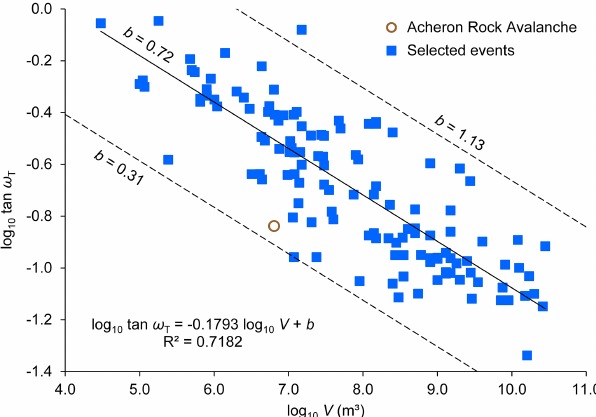
Figure 5. Empirical–statistical relationship relating the angle of reach ω T to the volume V of avalanching flows of rock or